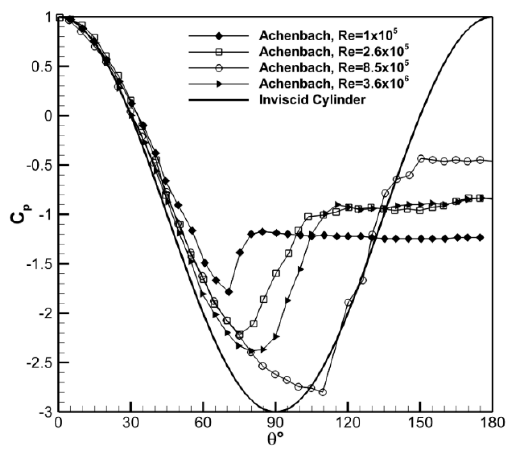
Figure 6. Pressure distribution around cylinder as a function of Reynolds number. Data from Achenbach [18].